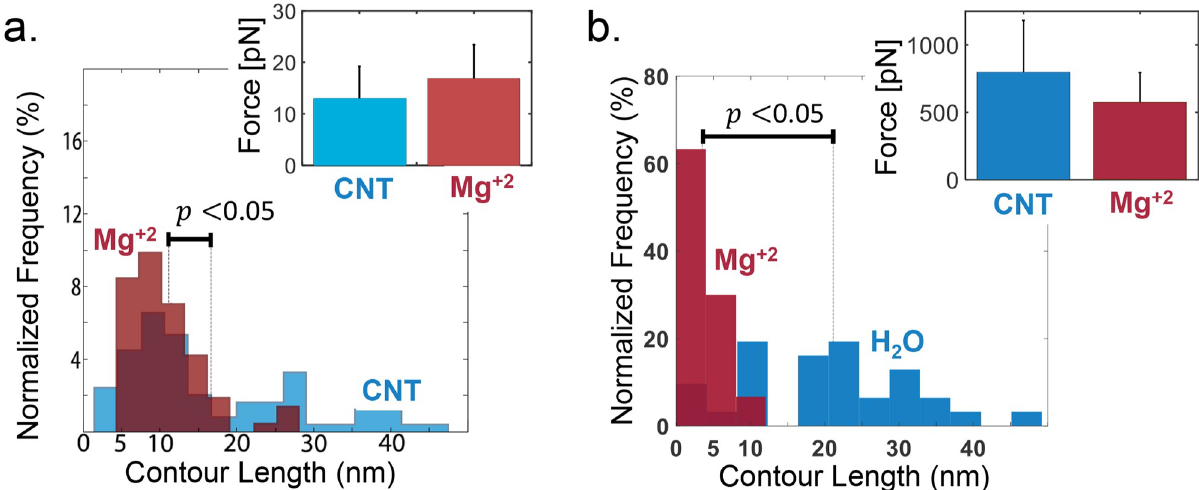
Fig 3. APTSTX1 aptamer stabilization with Mg +2 . (a) Comparison of the contour length histograms for the control (CNT, blue) and Mg +2 environment (red). Total number of rips (Unfolding and Refolding) considered are CNT: 79, Mg +2 : 71. The mean of distribution for Mg +2 treatment (10.8 nm) is clustered on a particular size and showing a significant difference ( p < 0.05). Inset, rupture force results in CNT (blue) and Mg +2 environment (red). Total number of rips considered (only Unfolding) are 45 and 43 for the control and Mg +2 environments, respectively. (b) Comparison of the contour length histograms for the control (CNT, blue) and Mg +2 environment (red). Total number of rips considered (only Unfolding) CNT: 31, Mg +2 : 35, showing a significant difference ( p < 0.05). Inset, rupture force for the APTSTX1 aptamer via SMD simulations in CNT (blue) and Mg +2 environment